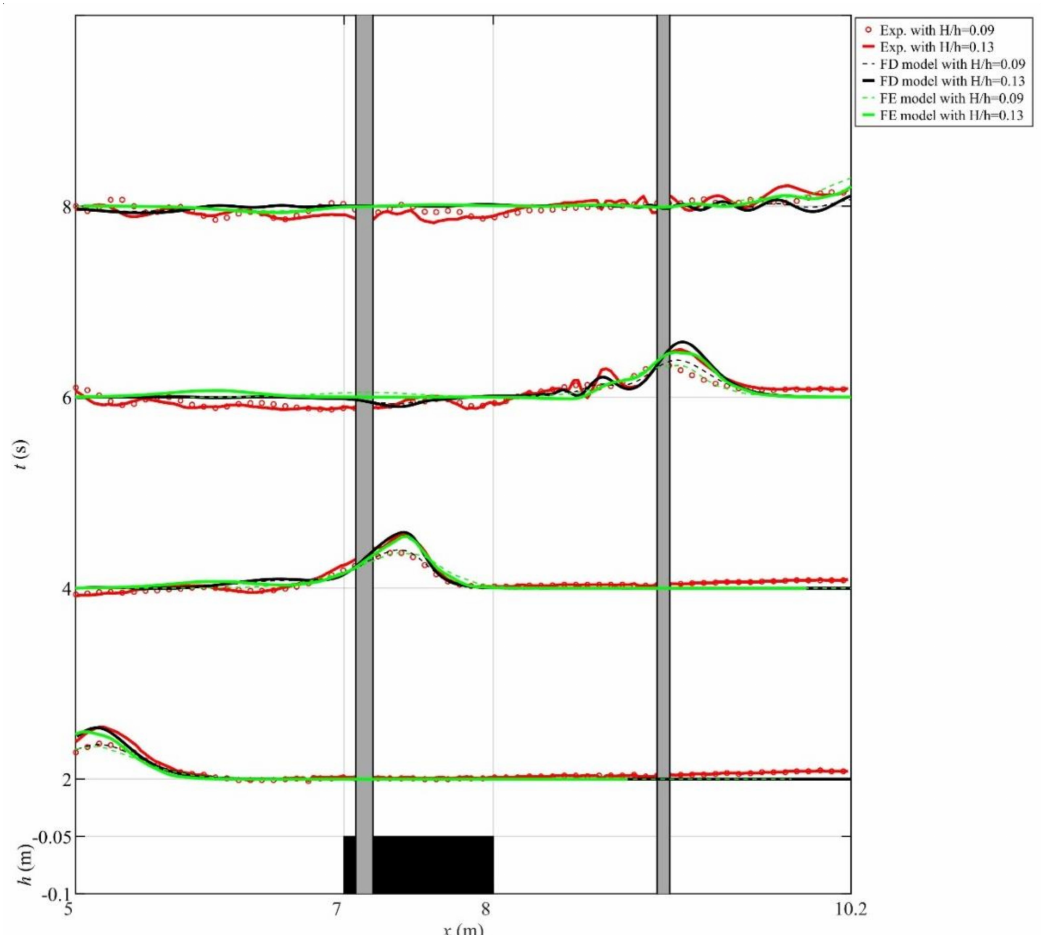
Figure 9. Snapshots of the wave profiles from bottom to top at t = 2, 4, 6, and 8 s (red circles and dashed lines denote H/h values of 0.09 and 0.13 for the experimental data; black dashed and solid lines denote H/h values of 0.09 and 0.13 for the FD model; grey dashed and solid lines denote H/h values of 0.09 and 0.13 for the FE